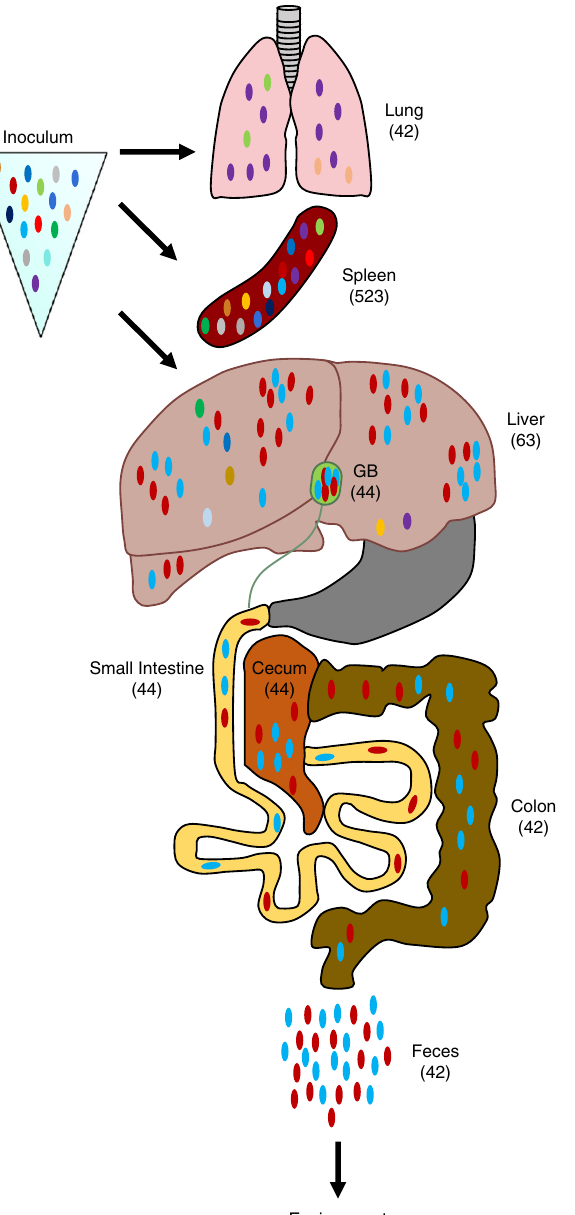
Fig. 6 Model of P. aeruginosa population dynamics following bloodstream infection. PA populations with unique complexity arise in the lungs, liver, and spleen of intravenously infected animals. The bottleneck sizes at 24 hpi within the liver and lung are similar (mean N b ′ values for all mice are shown in parentheses); however, their founding populations are distinct. Very few organisms establish infection in the gallbladder (GB), but the founders ultimately expand to very high numbers. Bacteria released from the GB through the bile into the small intestine become the principal source of PA excreted in the